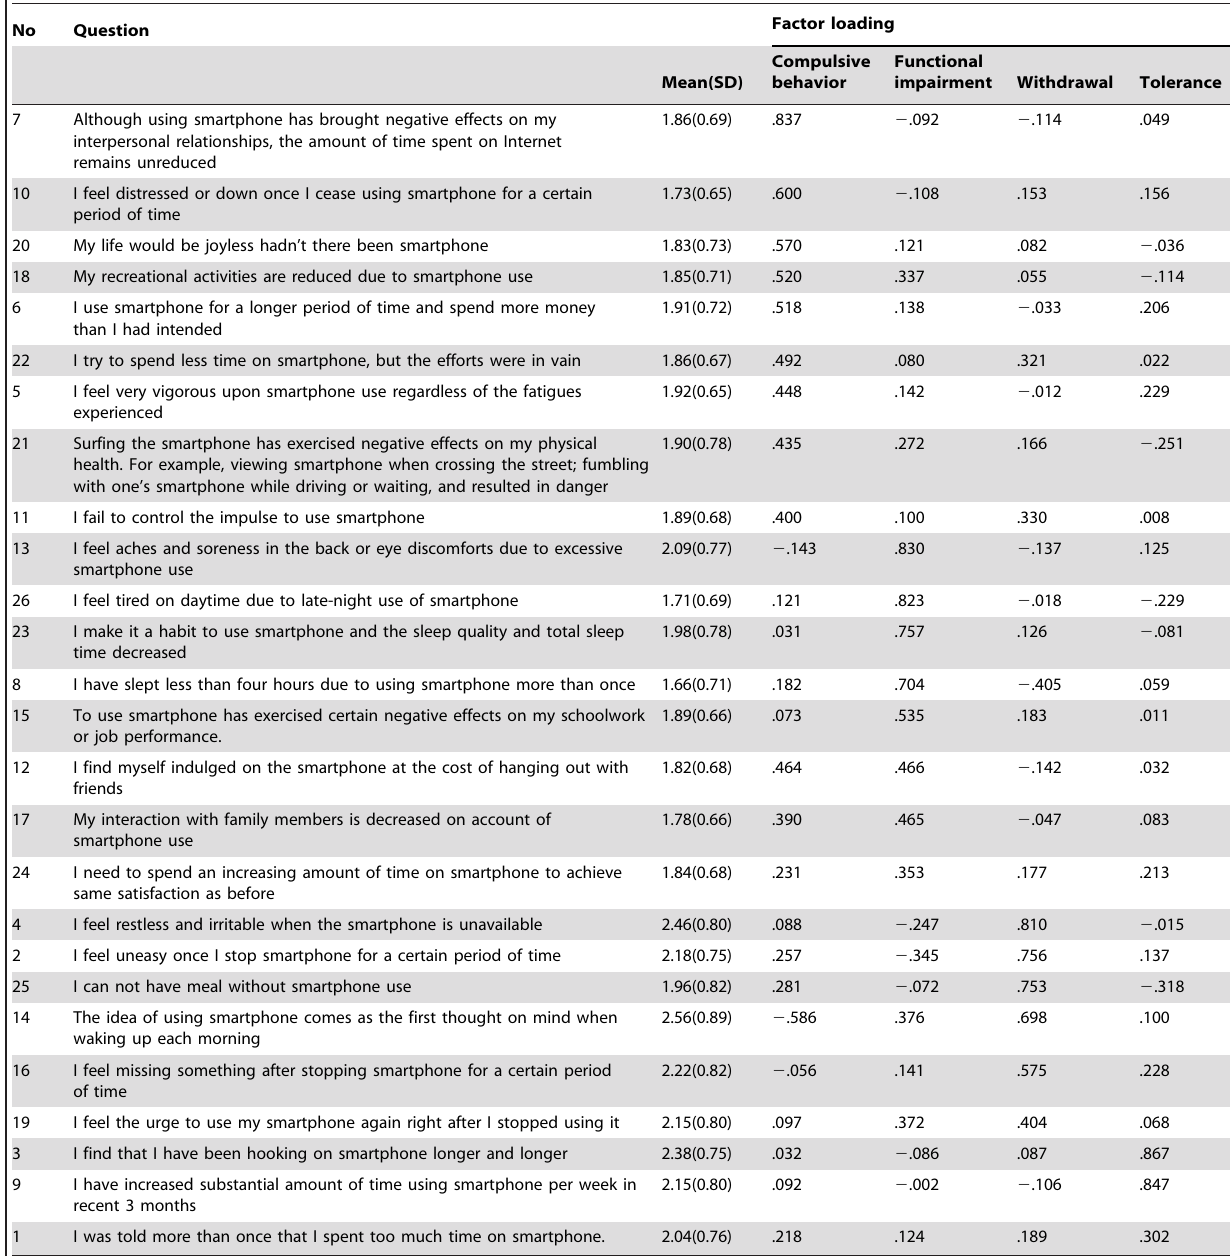
Table 1. Factor analysis for Smartphone Addiction Inventory